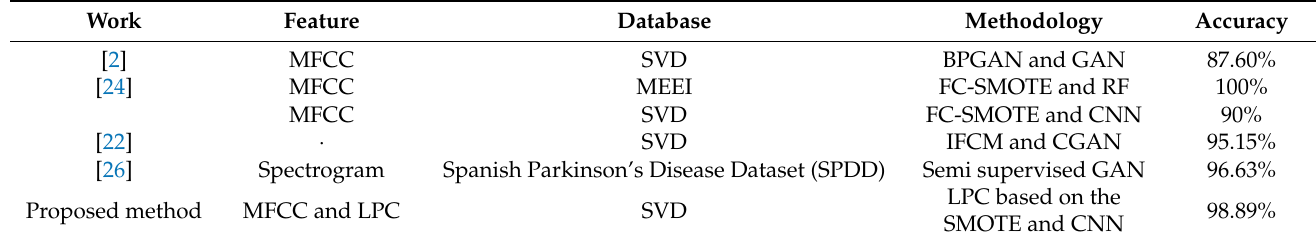
Table 6. Comparative analysis between related works tested on various